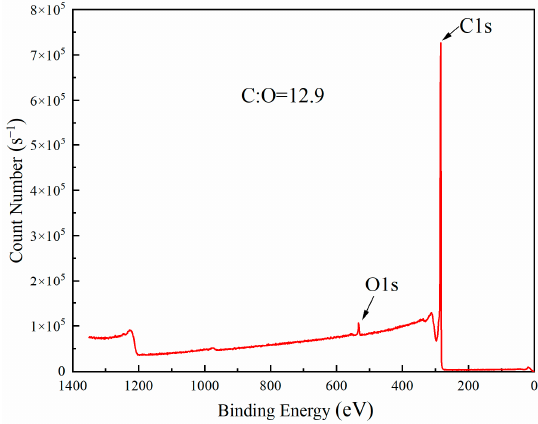
Figure 8. XPS spectrum of GDI PM.